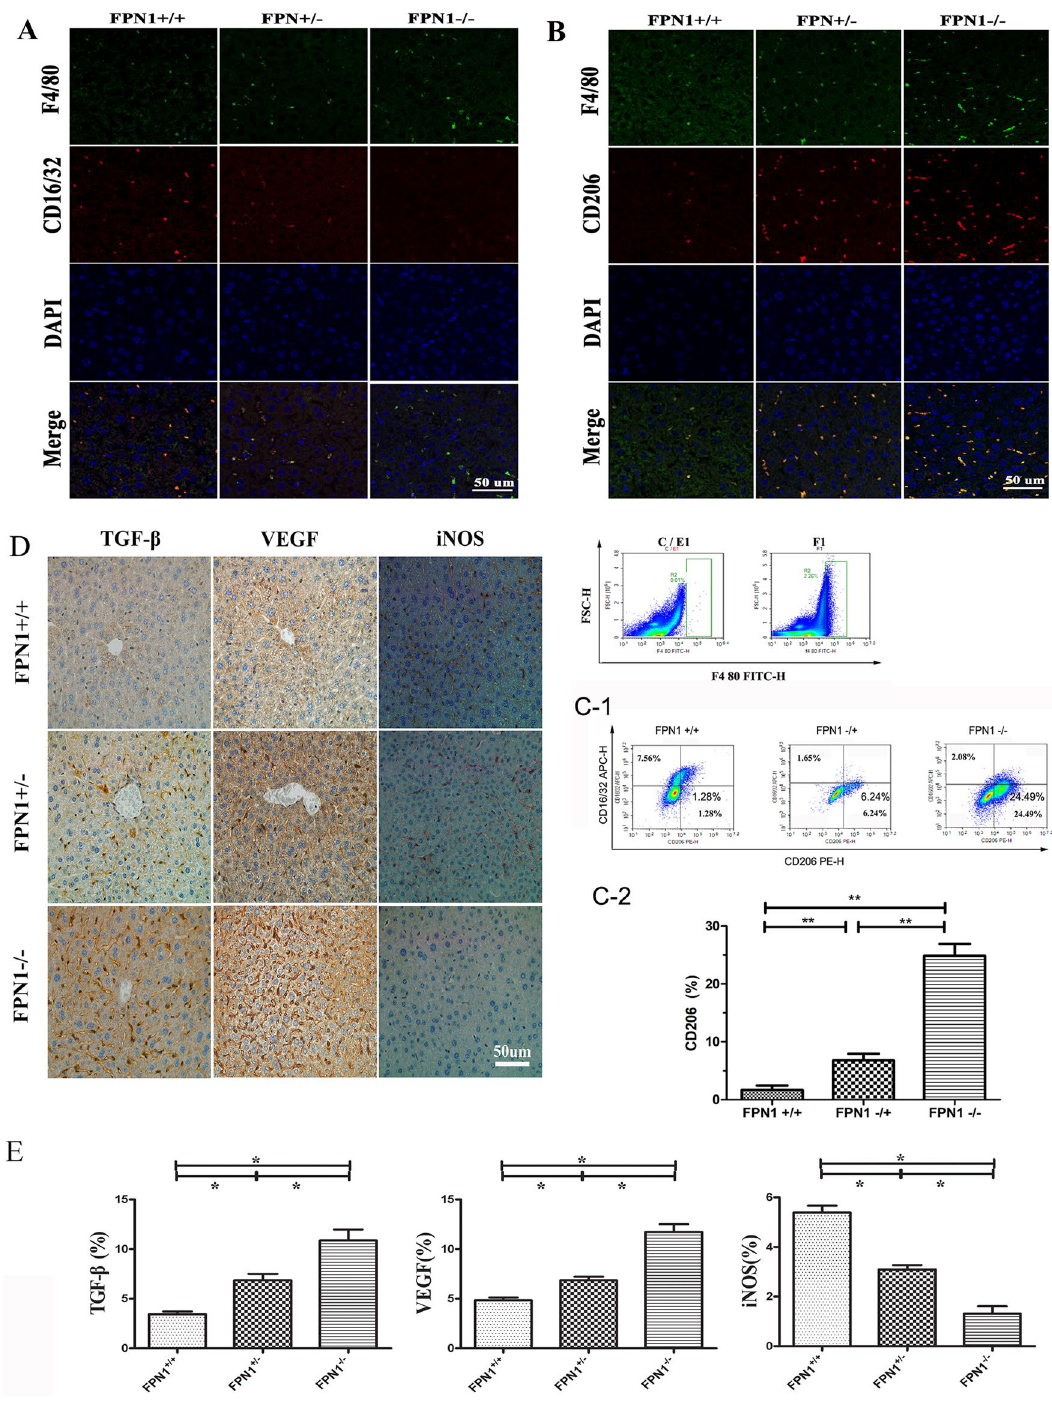
Figure 2. Downregulation of FPN1 in liver cells promoted M2 macrophage polarization in vivo. Liver sections were co-stained with F4/80 ( A ) and CD206 or CD16/32 ( B ). M1 macrophages were F4/80 high CD16/32 high , and M2 macrophages were F4/80 high CD206 high . ( C ) FCM analysis of the expression of specific biomarkers of macrophages in mouse livers. (1) Image of FCM. Single macrophage first identified by forward scatter height (FSC-H) versus F4/80 + gating using in the IgG control and F4/80 stained mouse liver cells; (2) CD206 expression level of FCM. ( D ) IHC analysis of the expression of M1 and M2 marker proteins in mouse livers. (1) Image of IHC; (2) TGF-β, VEGF and iNOS level of IHC. All results are from three independent experiments. * P < 0.05, ** P <